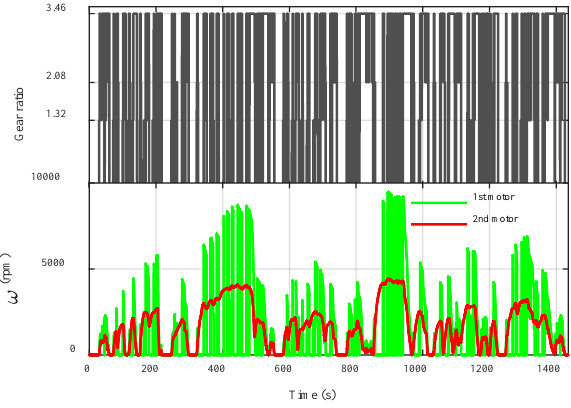
Figure 8. Gear shifting with the power-sharing strategy.